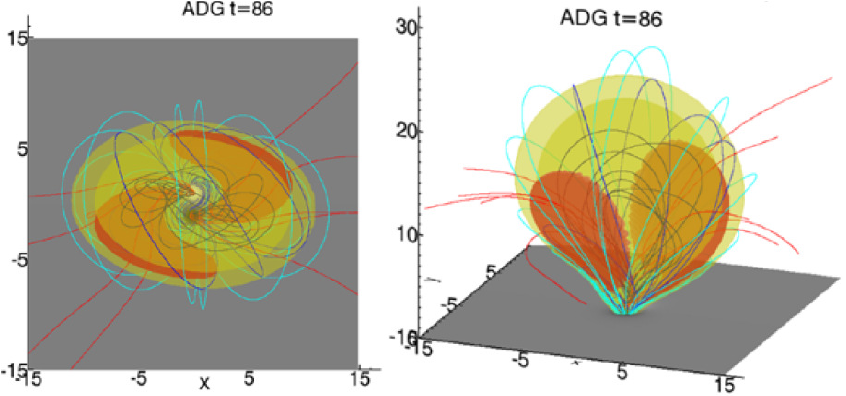
Figure 44: The current shell model. Depicted is the numerical simulation of an erupting flux rope. The colored surfaces represent the current shell that is induced at the outer edge of the flux rope. Left : projection onto the surface. Right : oblique view. Image reproduced with permission from Delann´ee et al. (2008), copyright by